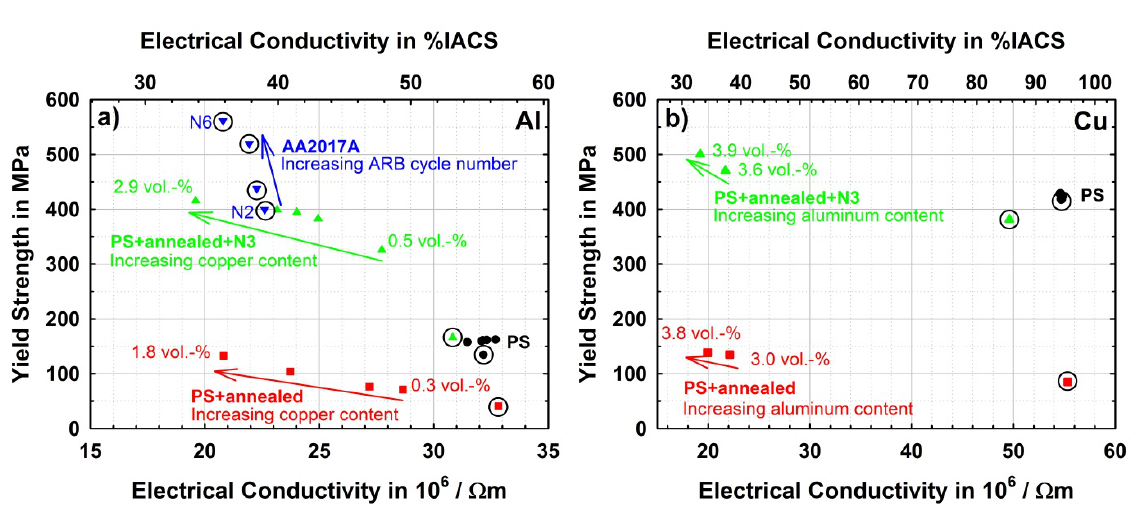
Figure 8. Yield strength and electrical conductivity of ( a ) aluminum based materials in different microstructural states; ( b ) copper based materials in different microstructural states. Please note: Unreinforced materials are labeled with a circle around the